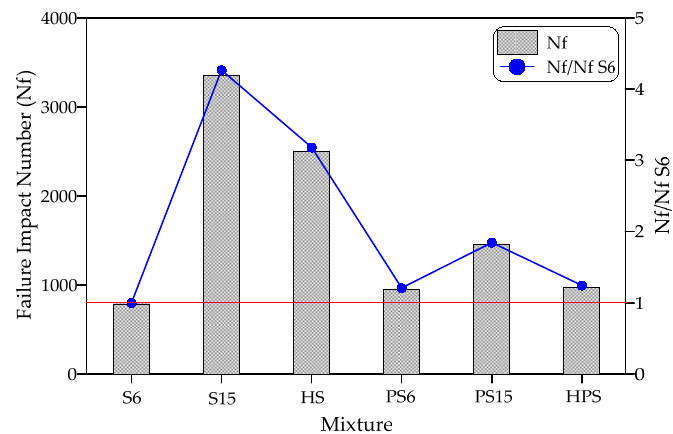
Figure 5. Repeated failure impact numbers.